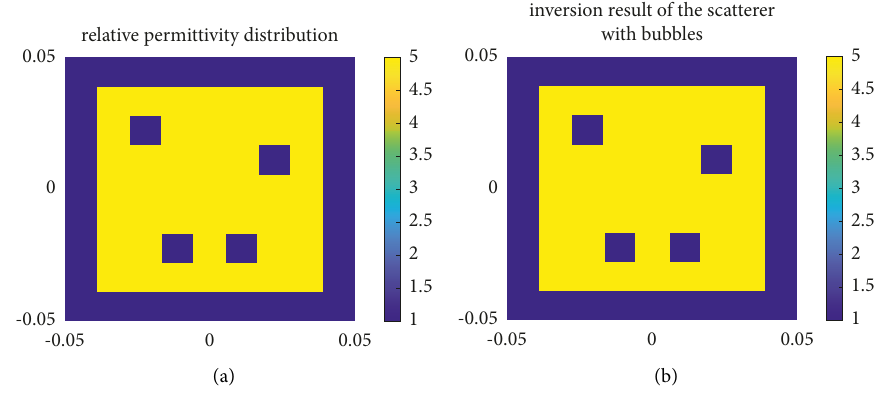
Figure 5: Comparison results of relative permittivity distribution of the scatterer with bubbles.